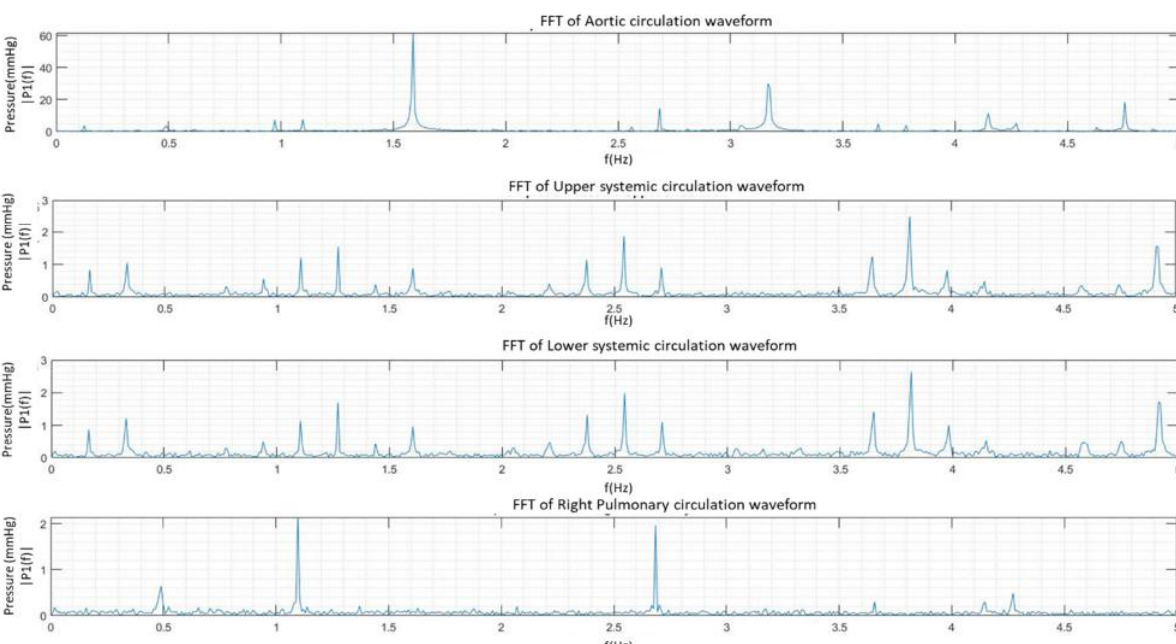
Figure 18. FFT on pressure waveform for the 3 mm IJS experiment.